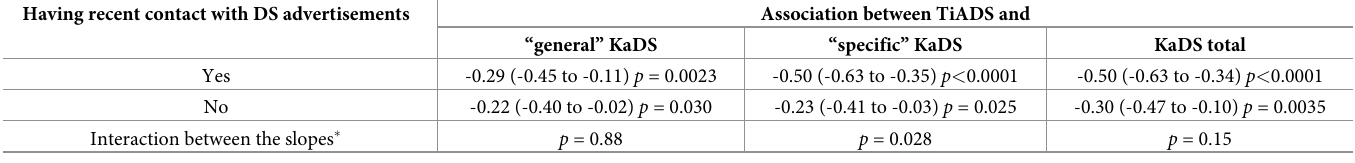
Interaction between the slopes